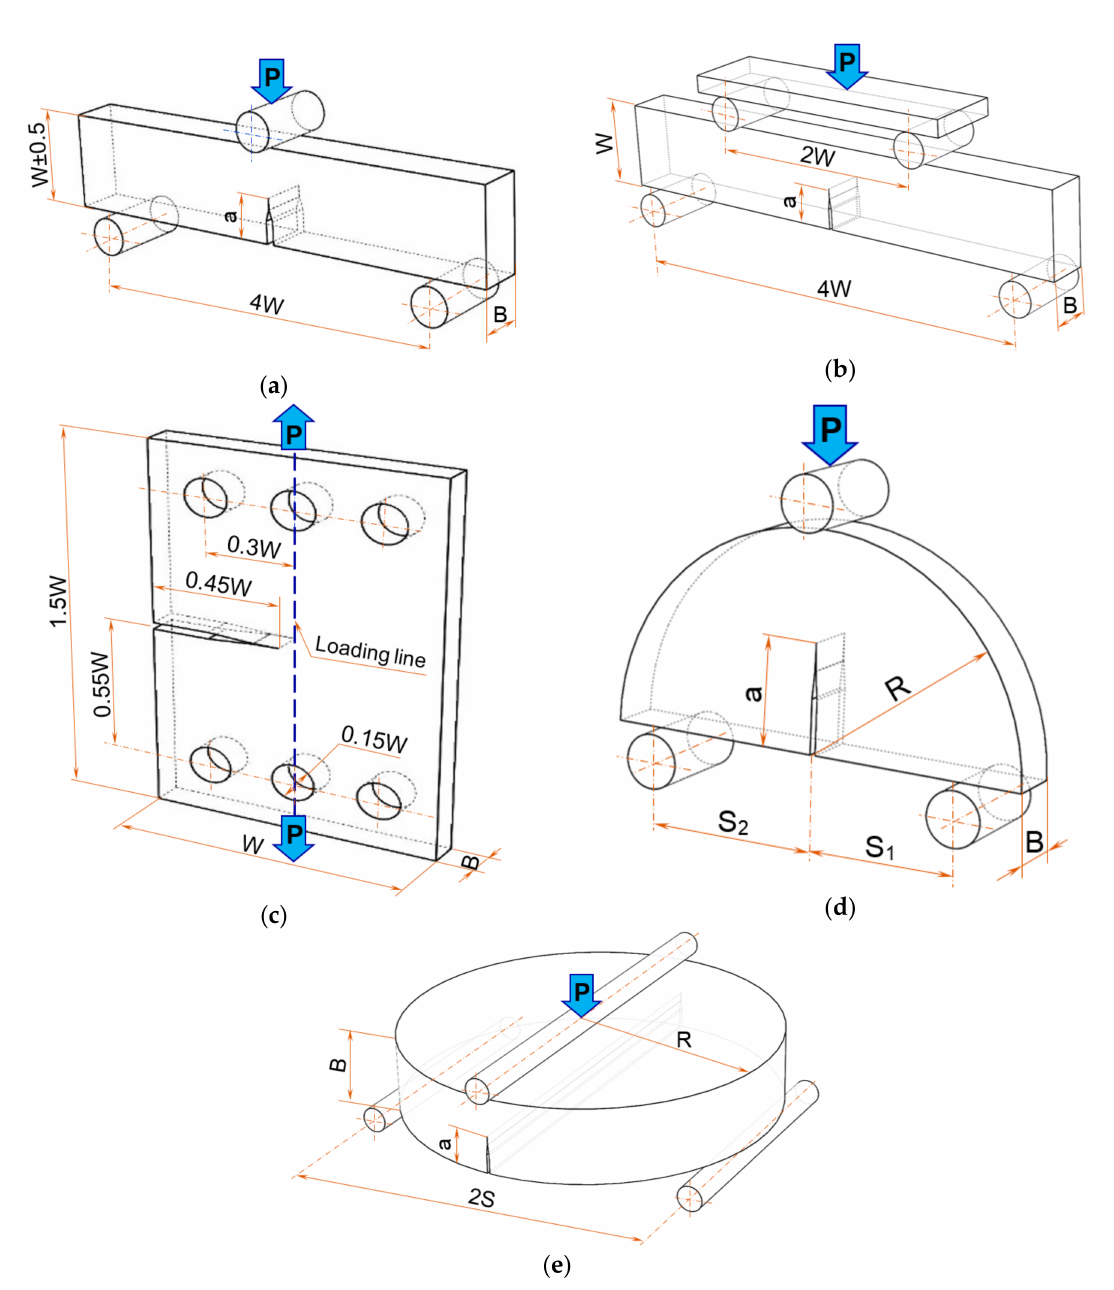
Figure 4. The geometry of the specimens and loading configuration of the fracture toughness tests: ( a ) Single Edge Notch Bend (SENB) specimen loaded in three point bending ( B = 12.5 mm, W = 25 mm, a = 12.5 mm); ( b ) SENB specimen loaded in four point bending ( B = 11.5 mm, W = 25 mm, a = 16.5 mm); ( c ) Single Edge Crack (SEC) specimen ( B = 8 mm, W = 75 mm, a = 33.75 mm); ( d ) Symmetric Semi Circular Bend (SCB) specimen ( R = 40 mm, B = 10 mm, S 1 = S 2 = 30 mm, a = 20 mm); ( e ) Edge Notch Bend Disc (ENDB) specimen ( R = 75 mm, B = 30 mm, a = 15